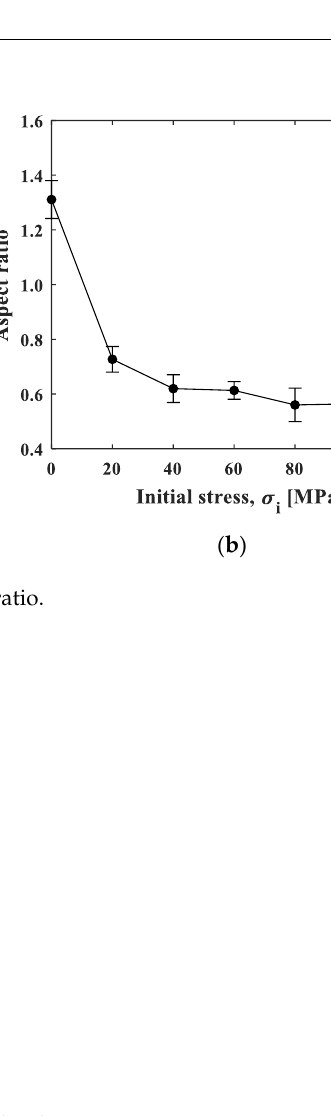
Figure 19. Strain – initial stress plot for area B obtained by the ESPI measurement. Figure 19. Strain–initial stress plot for area B obtained by the ESPI